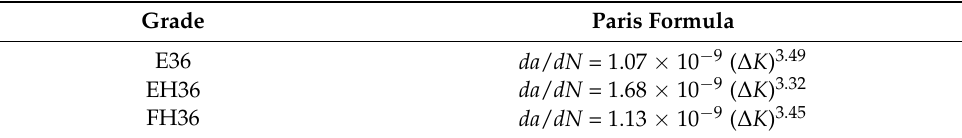
Table 5. Paris formulae for three grades of steel